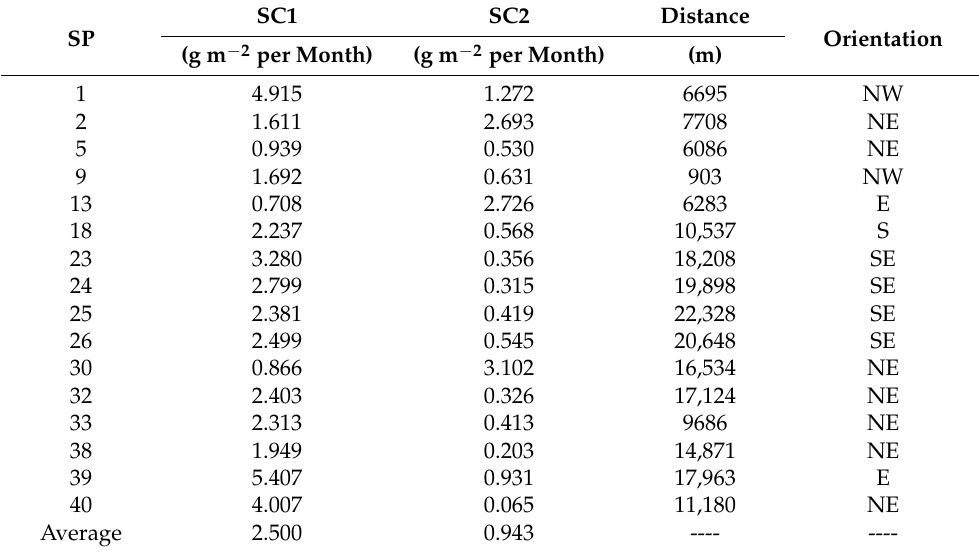
Table 4. Dust fallout in selected sampling points within the 20 km sampling area.